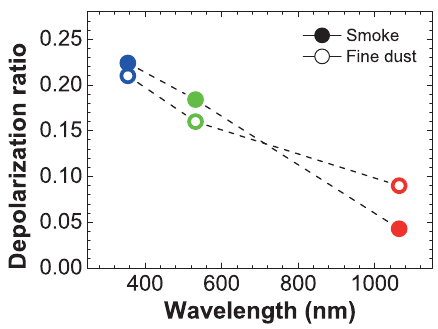
Figure 6. Spectral dependence of particle linear depolarization ra- tio for fine-mode desert dust and stratospheric accumulation-mode smoke